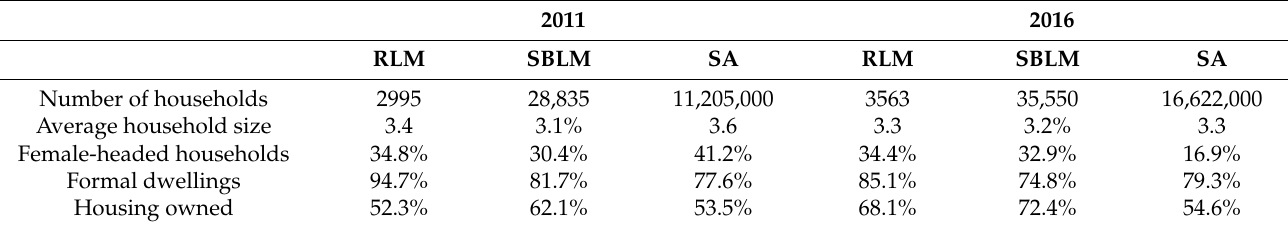
Table 2. Household dynamics in RLM and